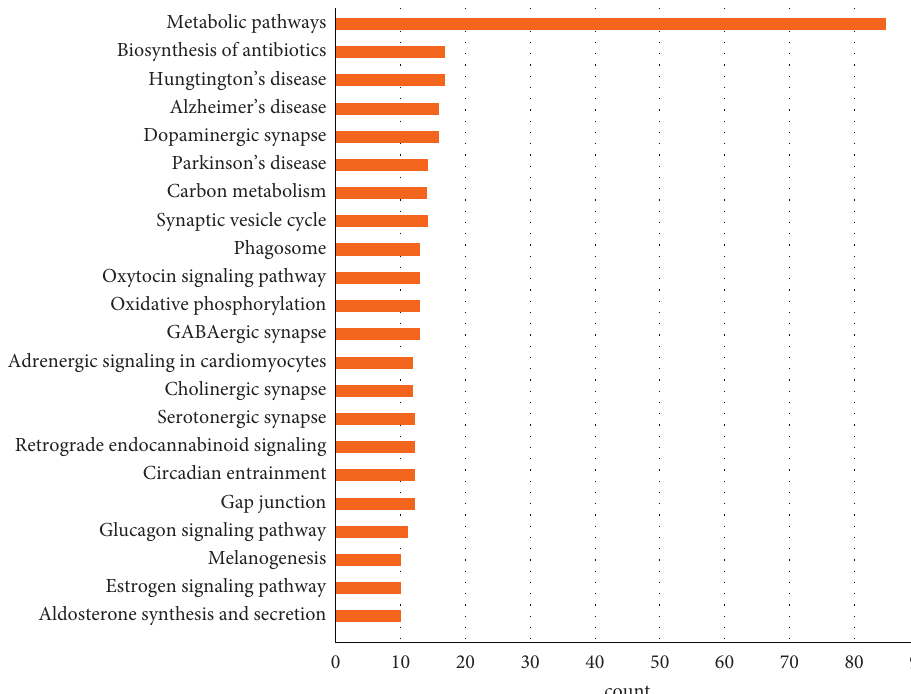
Figure 4: Enrichment analysis of the KEGG signaling pathway of DEGs. The numbers on the x -axis are gene counts.